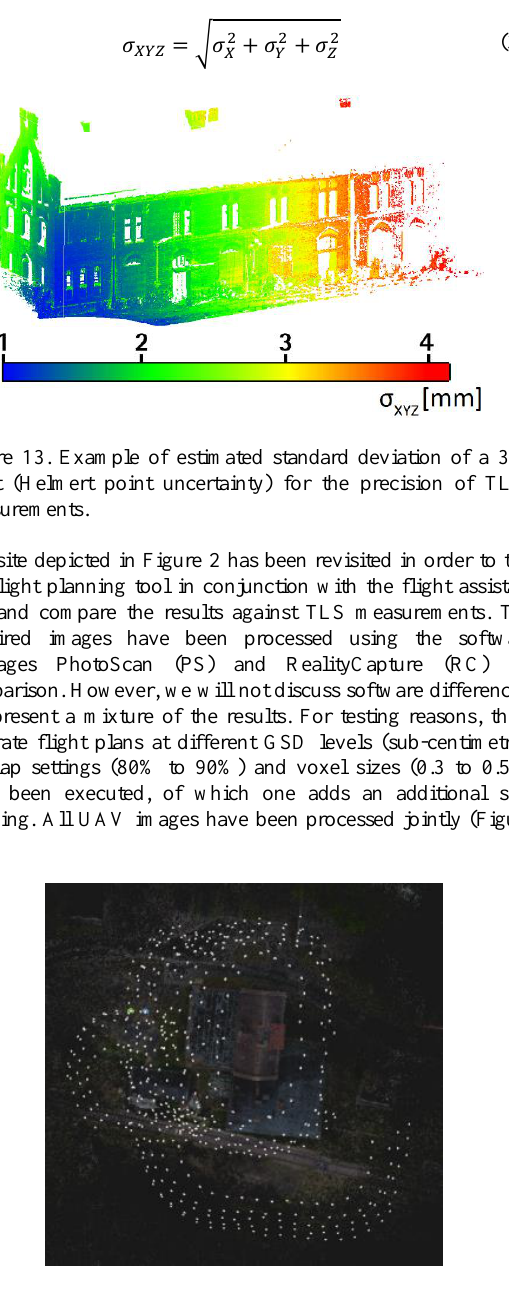
Figure 14: Bird’s eye view of the sparse reconstruction (RealityCapture) of the building depicted in Figure 2. Here, the image acquisition was planned and executed using the described software